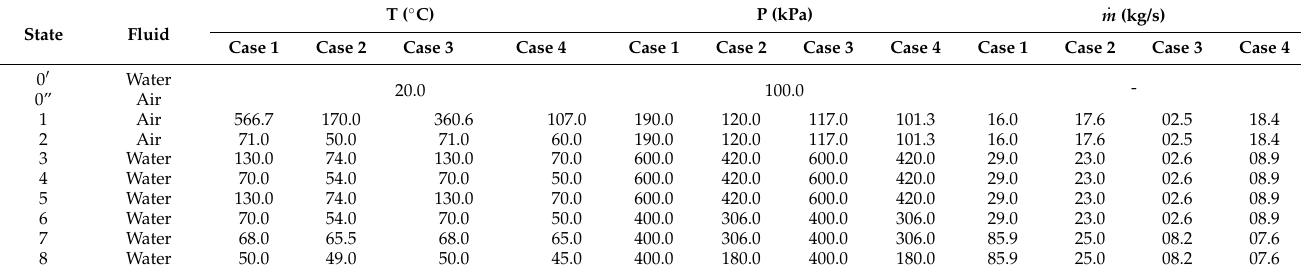
Table 1. Thermo-physical properties of the state points given in Figure 1 based on created cases.